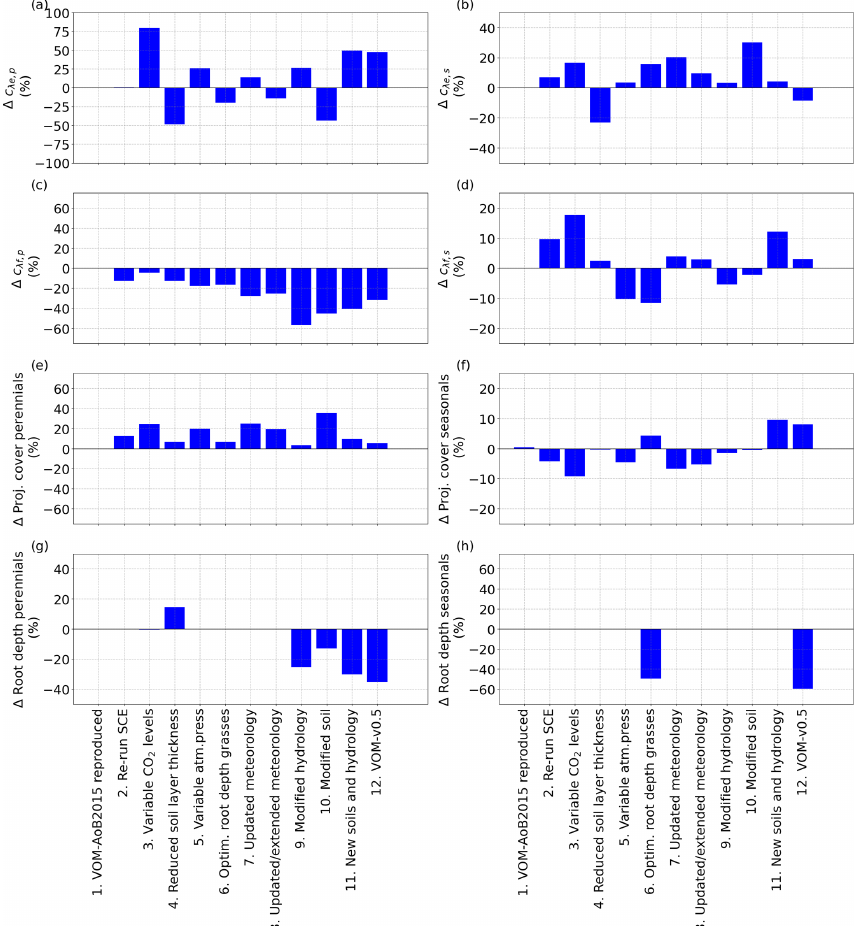
Figure 4. Relative changes in the vegetation properties for the different (incremental) changes, as described in Sect. 2.2.9, in comparison with the VOM-AoB2015, for (a) the water use parameter c λ e , p for perennial vegetation, (b) the water use parameter c λ e , s for seasonal vegetation, (c) the water use parameter c λ f , p for perennial vegetation, (d) the water use parameter c λ f , s for seasonal vegetation, (e) projected cover perennials (trees), (f) mean projected cover seasonals (grasses), (g) root depth perennials (trees) and (h) root depth seasonals